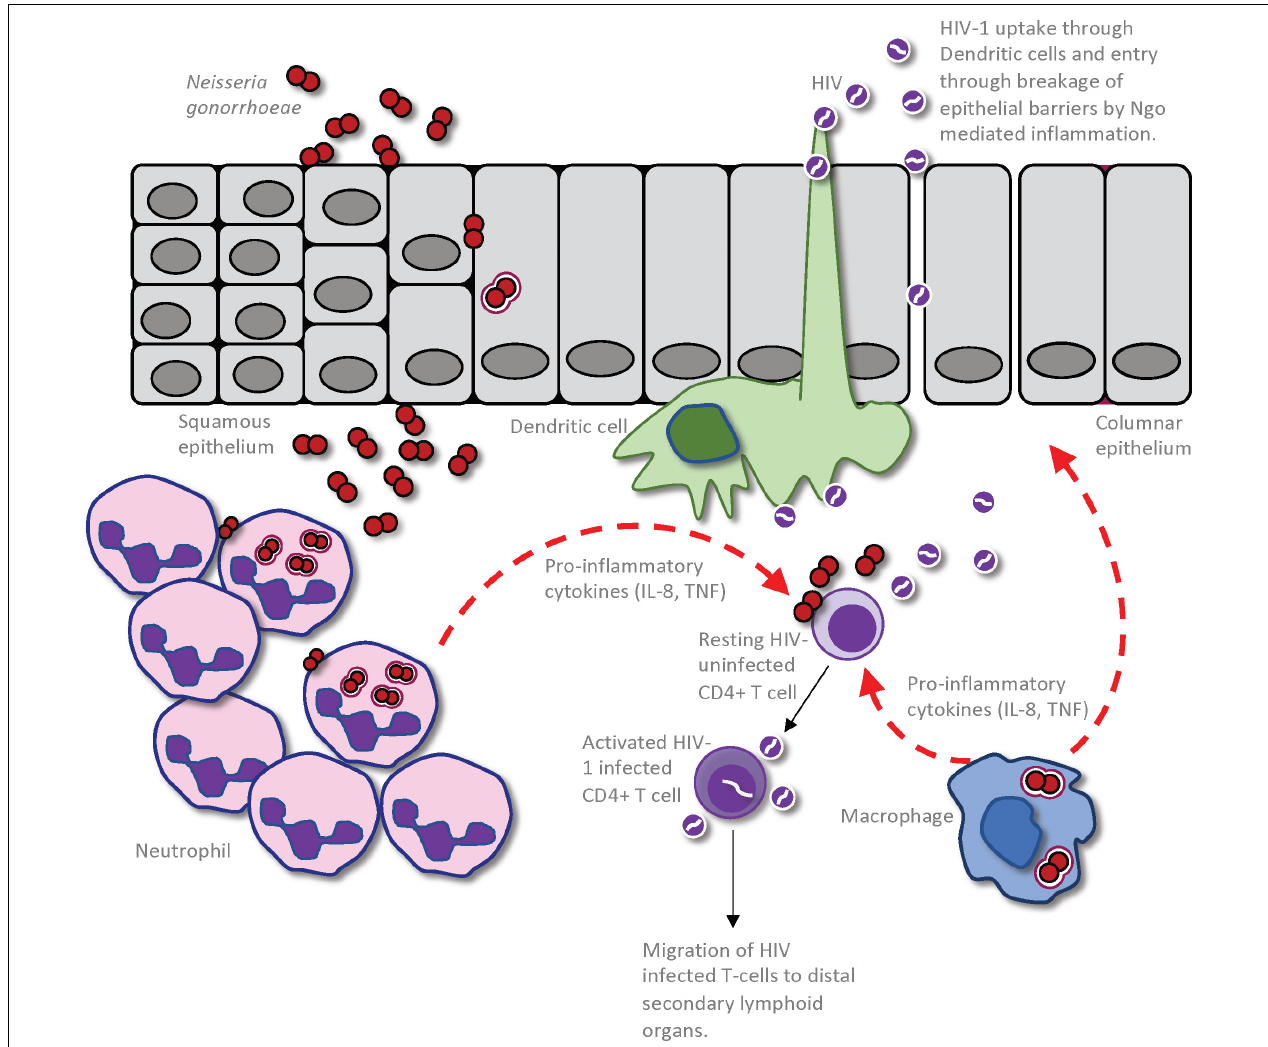
FIGURE 2 | Impact of Neisseria gonorrhoeae infection on establishment of HIV infection in a seronegative individual. The gonococcus may cause an increased susceptibility to HIV infection through a combination of the inflammation-induced damage of the epithelial barrier and increased inflammation within the genital microenvironment. This allows enhanced entry of HIV into the submucosa, either through dendritic cells (DCs) that are sampling the mucosal environment or through disrupted epithelium. Given that the gonococci cause an intense localized inflammation, as evidenced by an extensive neutrophil influx to the site of infection, CD4 T-cells that are recruited to the site of infection will be activated by the cytokines and other inflammatory mediators so as to become optimal targets for HIV infection and replication. Macrophage that are recruited to the site of gonococcal infection may also produce pro-inflammatory cytokines and chemokines to simultaneously activate local CD4 T-cells and recruit further HIV-receptive target cells. Furthermore, the macrophages or DCs can take up the HIV present in the genital microenvironment and travel to distal secondary lymphoid organs where they can further promote HIV infection of CD4 T-cells in these regions.